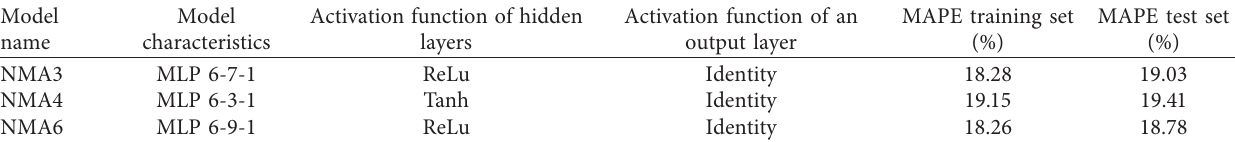
Table 8: Artificial neural network models for estimating reinforcement consumption (min-max normalization). Model